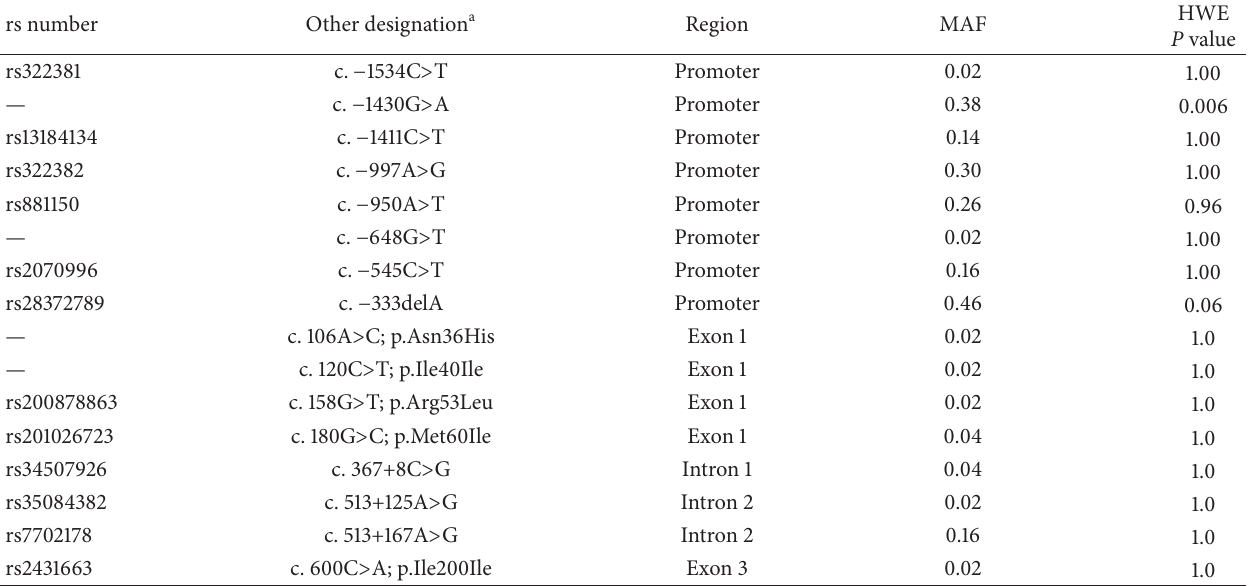
Table 2: Characteristics of DUSP1 sequence variations identified by direct sequencing in 25 severely obese